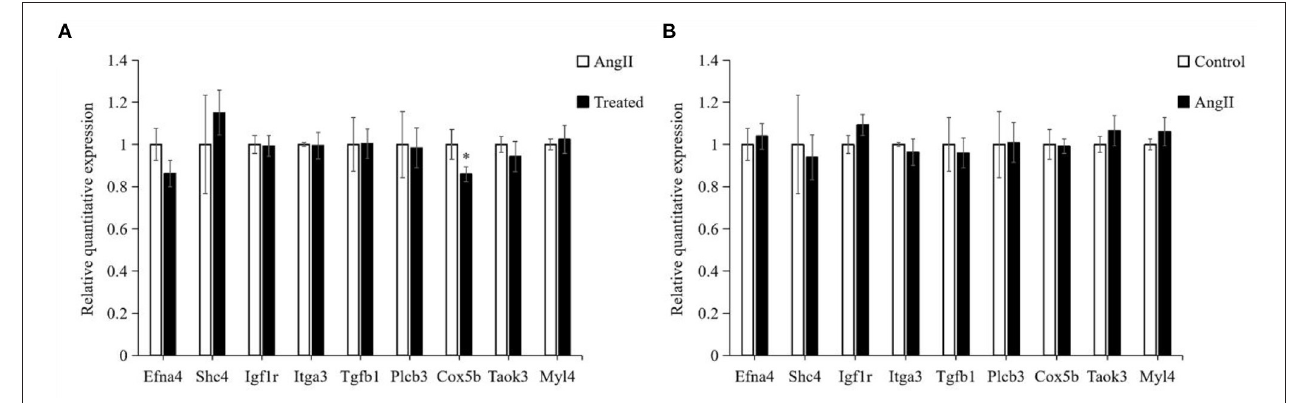
FIGURE 9 | Verification of identified differentially expressed genes (DEGs) in VSMCs by RT-PCR. (A) mRNA expression of identified DEGs in the FPQYLQYPY treated group and Ang II-treated group. (B) mRNA expression of identified DEGs in the Ang II-treated group and control group. All the data are represented as the mean ± SD. * P <